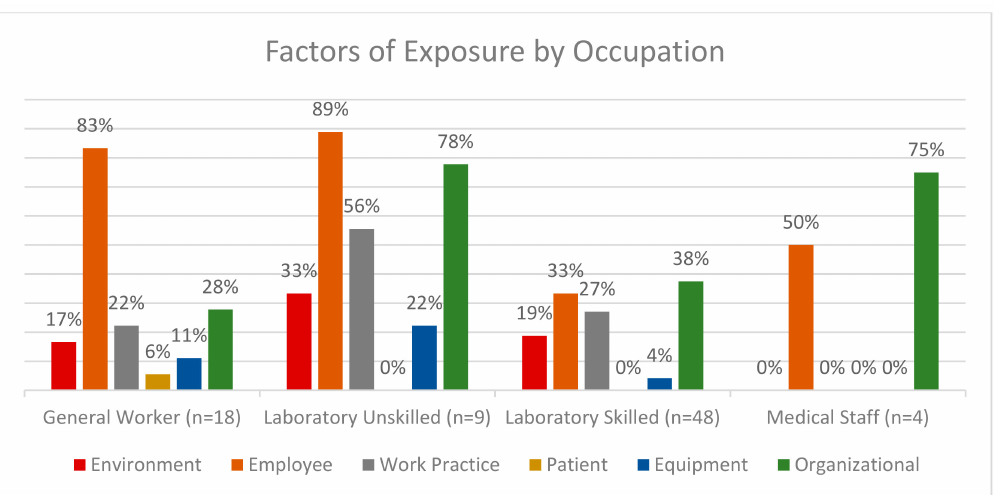
Figure 1. Factors Contributing to TB Exposure by